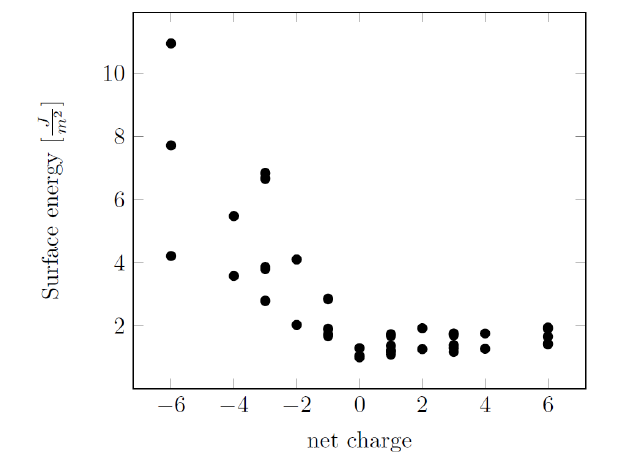
Figure 2. Calculated (PBE-D3(BJ)) surface energy against the net charge of the surface layer.